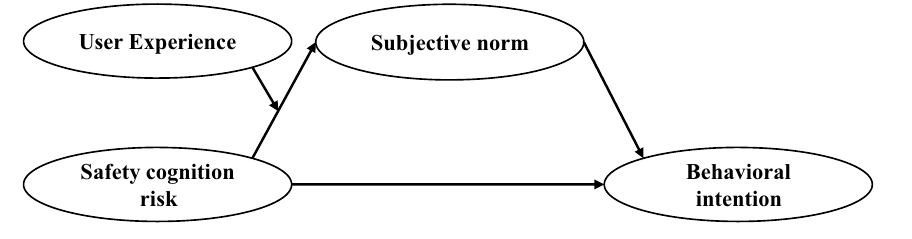
Figure 3. Mediation model with moderating